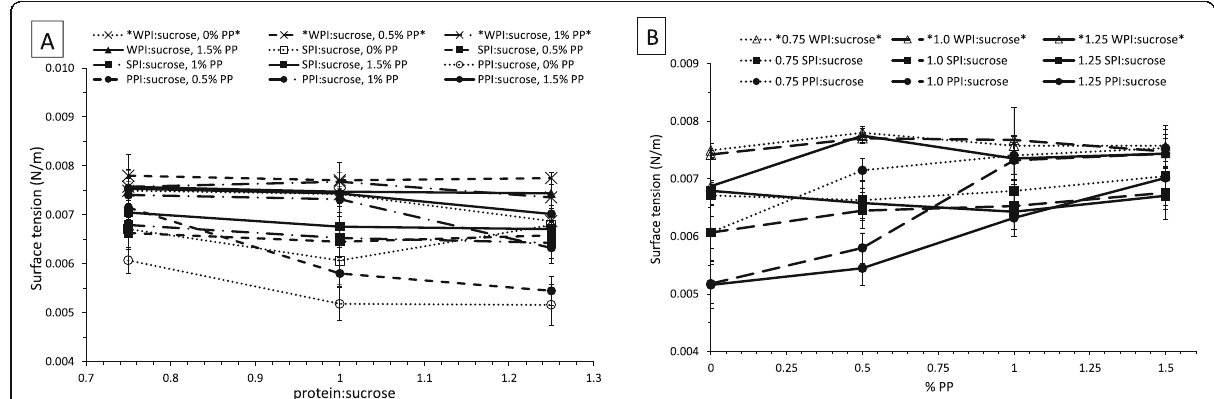
Fig. 1 Effect of protein:sucrose ratio ( A ) and PP content (%) ( B ) on the calculated surface tension (N/m) of dispersions at 25 °C; (averaged data plotted, n = 9). Legend entries marked * contain data reported in previous work (Hansen et al., 2021a; averaged data plotted, n = 6). Lines are for guiding purposes